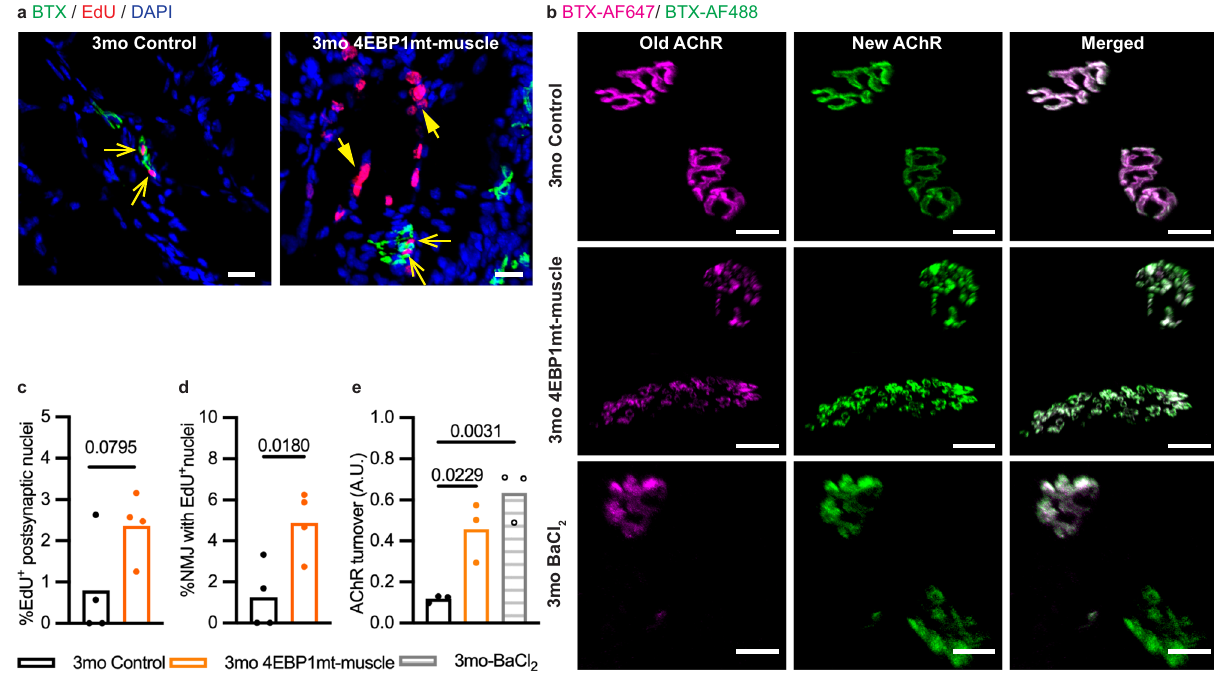
Fig. 7 | 4EBP1 activation increases the rate of AChR turnover. a Representative confocal images of BTX (green),EdU (red) and DAPI (blue) staining oflongitudinal sections of the quadriceps muscle from 3-month-old male mice (3mo Control and 4EBP1mt-muscle, n =4 per group). Open arrows=EdU-positive post-synaptic myonuclei;Solidarrows=EdU-positivenon-synapticmyonuclei.Scalebar=50 μ m. b Representative confocal images showing ‘ Old AChR ’ labeled with BTX-AF647 (magenta) and ‘ New AChR ’ with BTX-AF488 (green) from longitudinal sections of the tibialis anterior muscle of 3-month-old Control ( n =3) and 4EBP1mt-muscle ( n =3) male mice as well as control mice treated with BaCl 2 to induce muscle